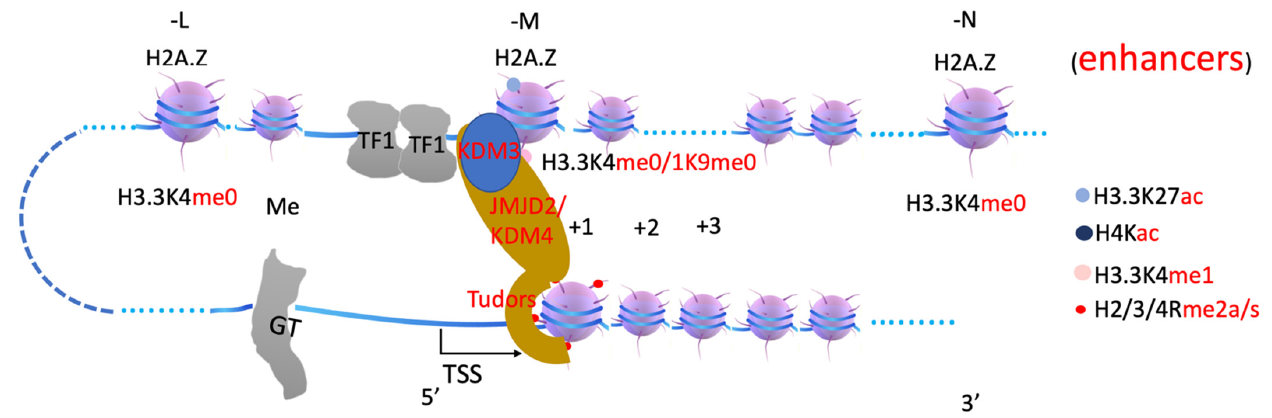
Figure 5. A model of transcription of how KDM3/4 is recruited by arginine methylated histone on +1 nucleosome. KDM3/4 are H3K9 and H3K36 specific lysine demethylases to remove methyl groups on H3.3K9 at enhancer regions. Tudor domain is specific to recognize arginine methylated histone tails at +1 nucleosome.